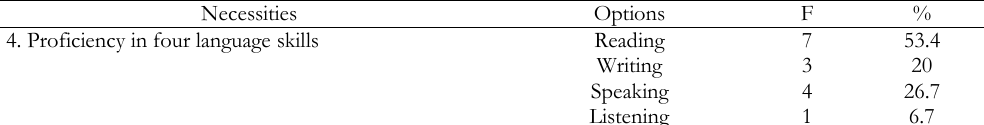
TABLE 4. S tudents’ perceptions of their proficiency in the four language skills.